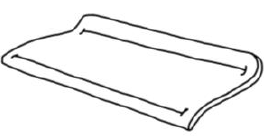
Figure 34. US Patent 3,468,582 Honeycomb structure [16].